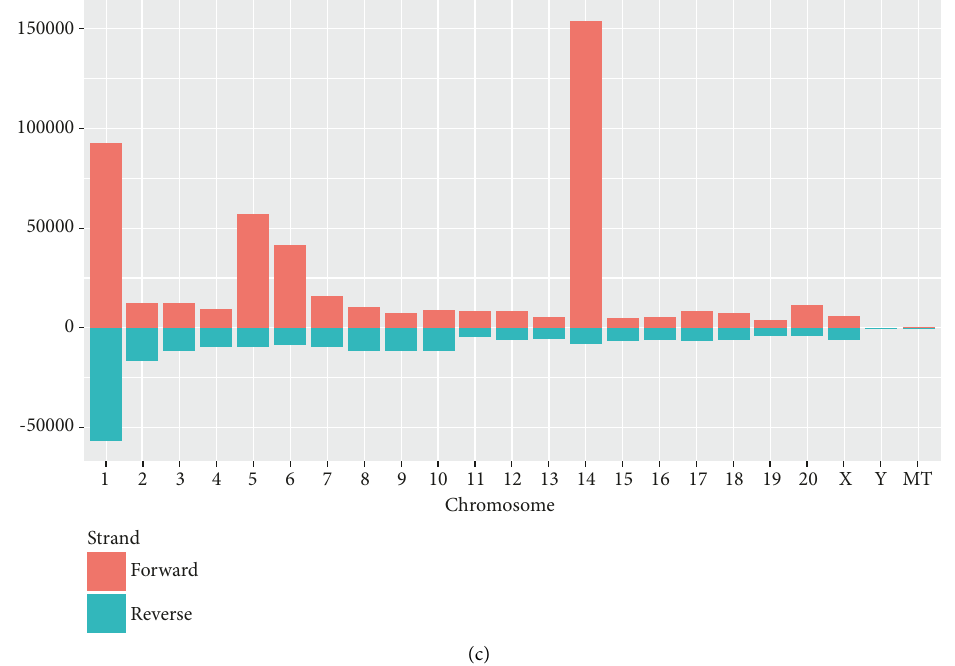
Figure 3: miRNA profile of exosomes isolated from ex vivo rat lens culture medium. (a) The top ten known miRNAs in the exosomes released by LECs. (b) The top ten novel miRNAs in the exosomes released by LECs. (c) Chromosome distribution of exosomal miRNAs.